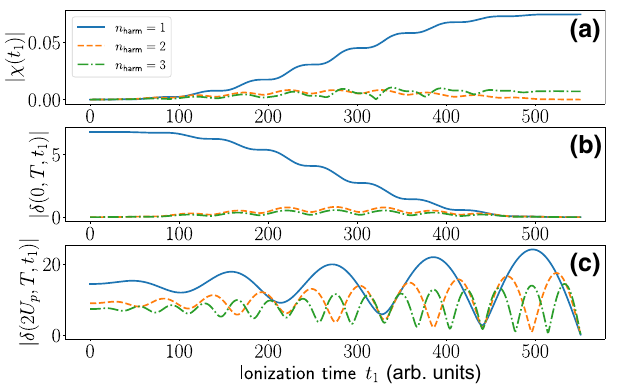
FIG. 5. Behavior of the shifts | χ( t 1 ) | [in (a)] and (cid:21) ω ) | [(b) p = 0 and (c) p = 0.93 | δ( T , t U p ] over ion- 1 , k , p ization time t 1 . The different curves in each of the plots represent contributions to different harmonic modes ( n harm ). In particular, the blue solid curve corresponds to the fundamental mode n = 1, the orange dashed curve to the second harmonic n = 2, and the green dash-dot curve to the third harmonic n = 3. In general, the displacement from | χ( t 1 ) | is, at least, 2 orders